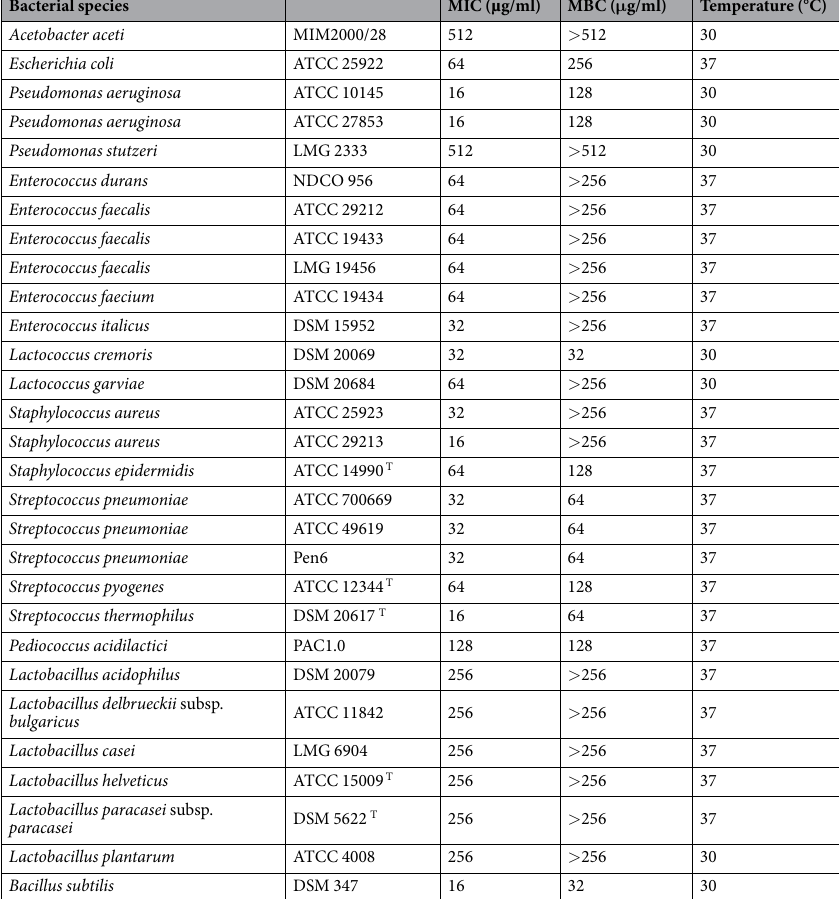
Table 1. Minimal inhibitory concentration (MIC) and minimal bactericidal concentration (MBC) values of promysalin against Gram-negative and Gram-positive